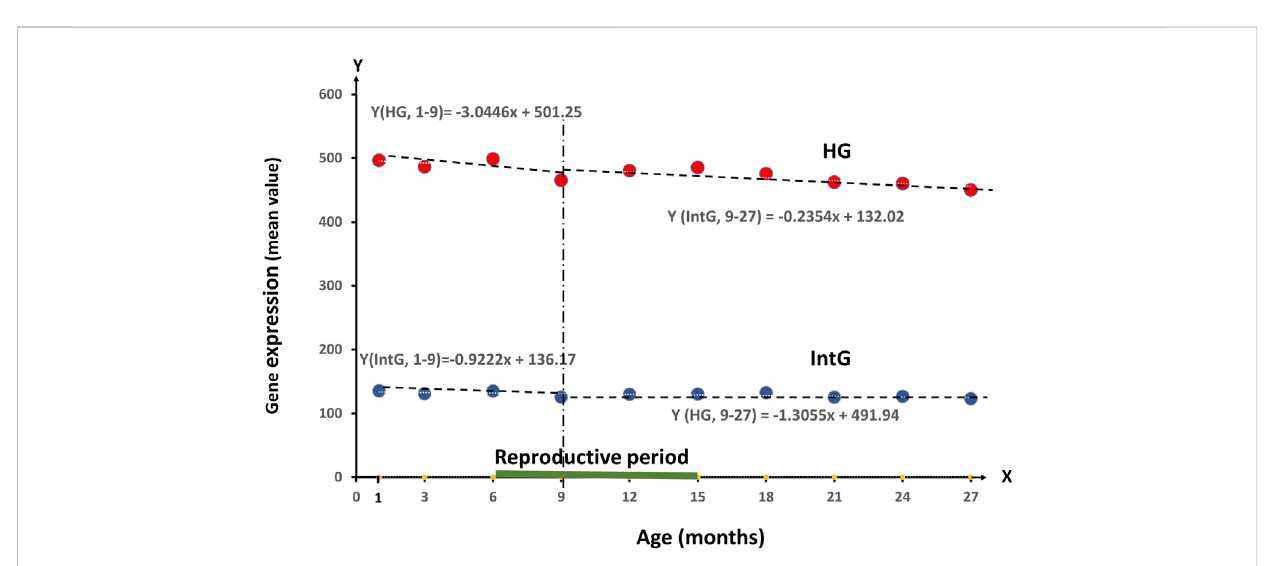
FIGURE 1 Dynamics of RNA production value of all genes divided into HG and IntG groups in the period from 1 month to 27 months .